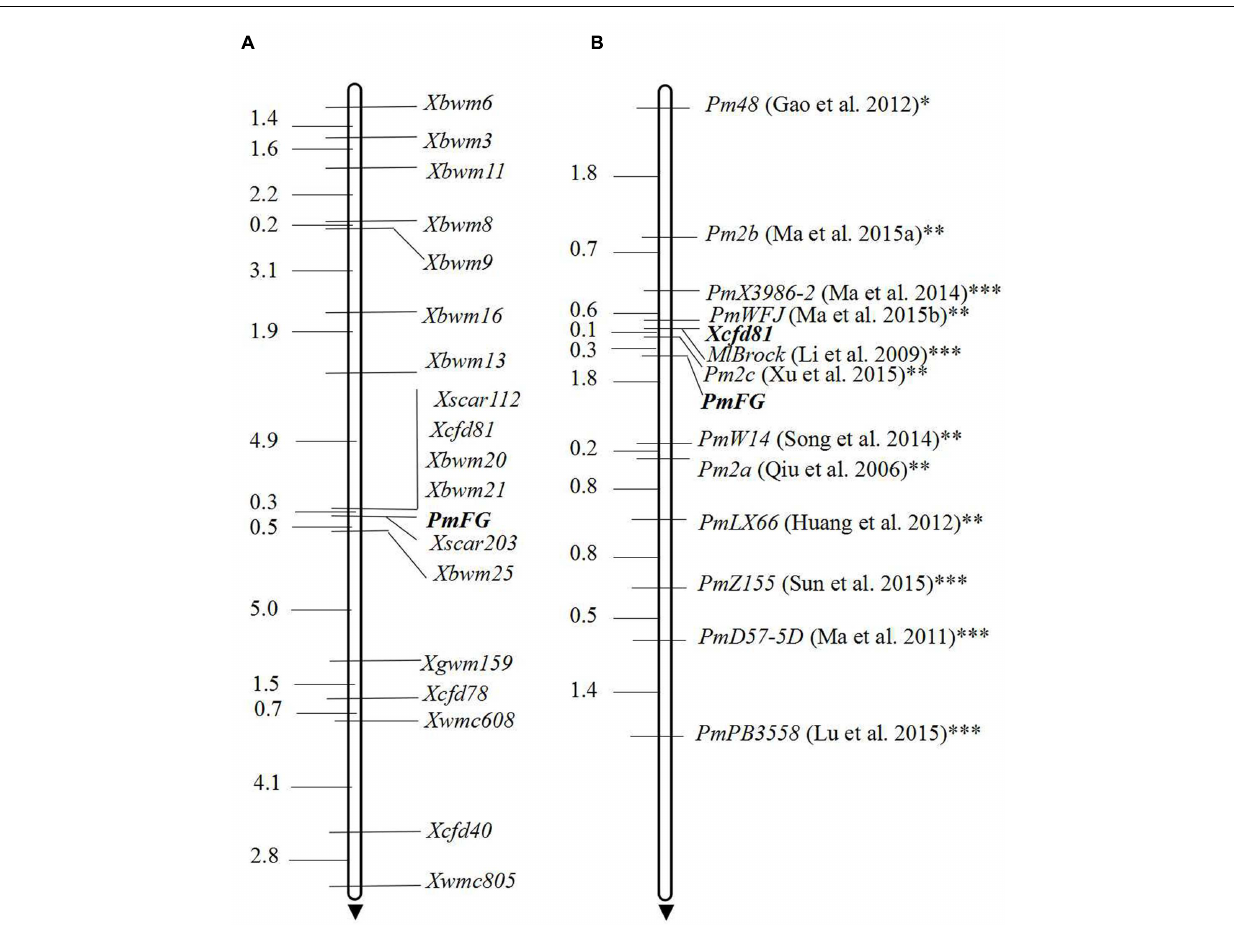
Frontiers in Plant Science |